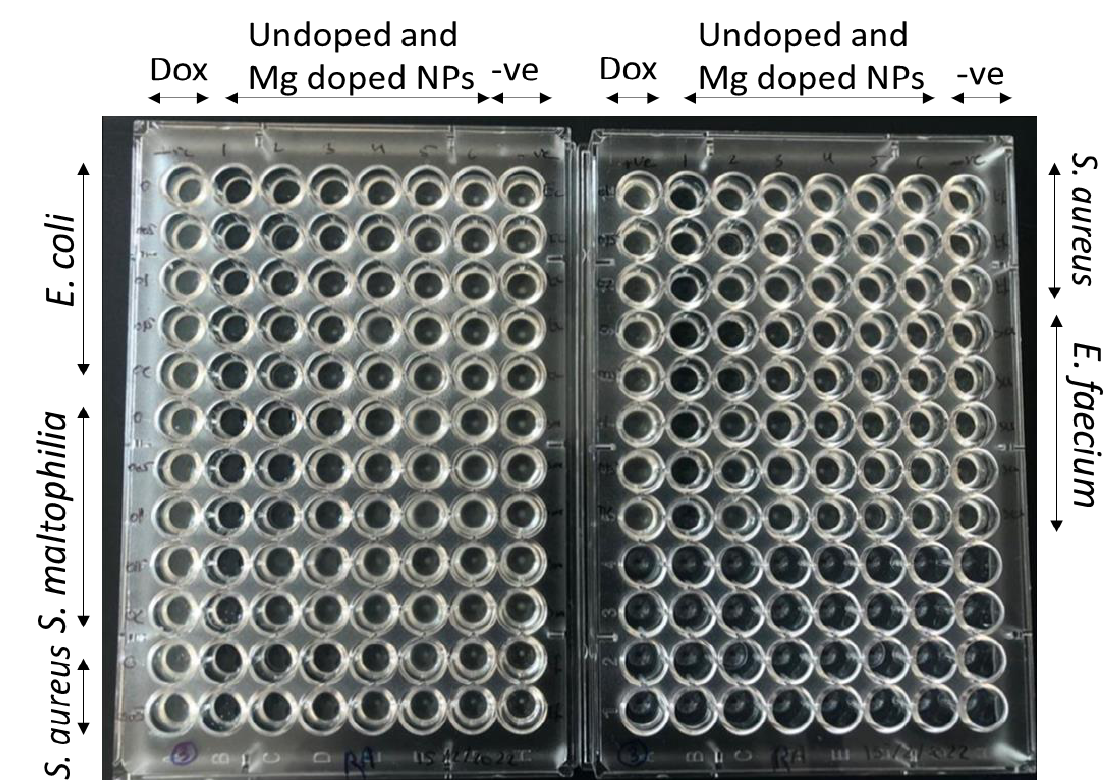
Figure A2. MIC results of the undoped and Mg-doped CuO NPs against four bacterial isolates.